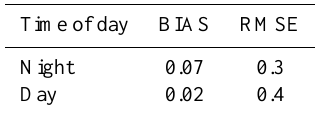
Table 1. Values for night and day mean scores for the 17-day hind-